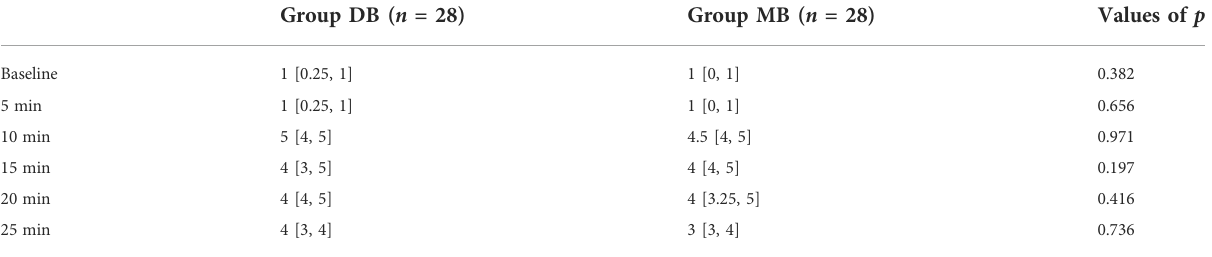
TABLE 3 Visual analogue scales of the two study groups.